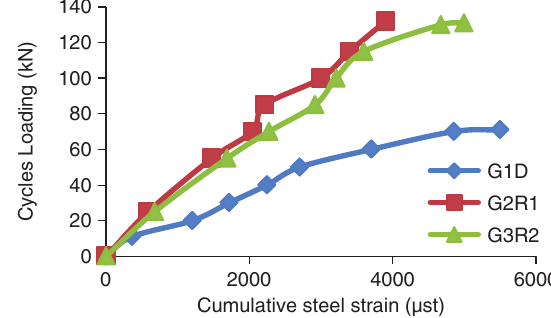
Fig. 7. Load against the cumulative steel strain of the tested beams